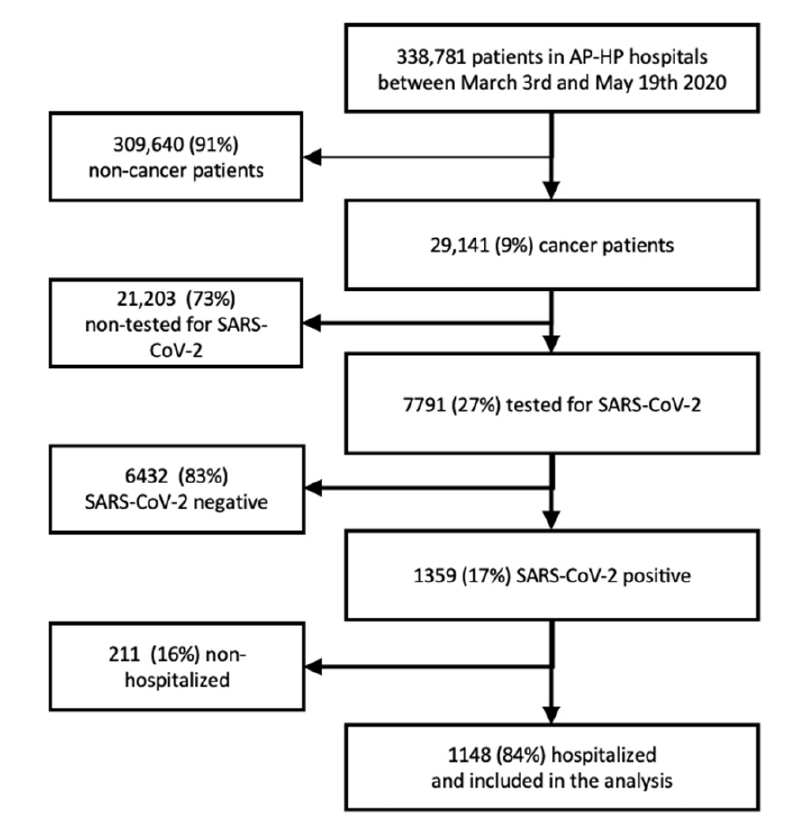
Figure 1. Flow-chart of the